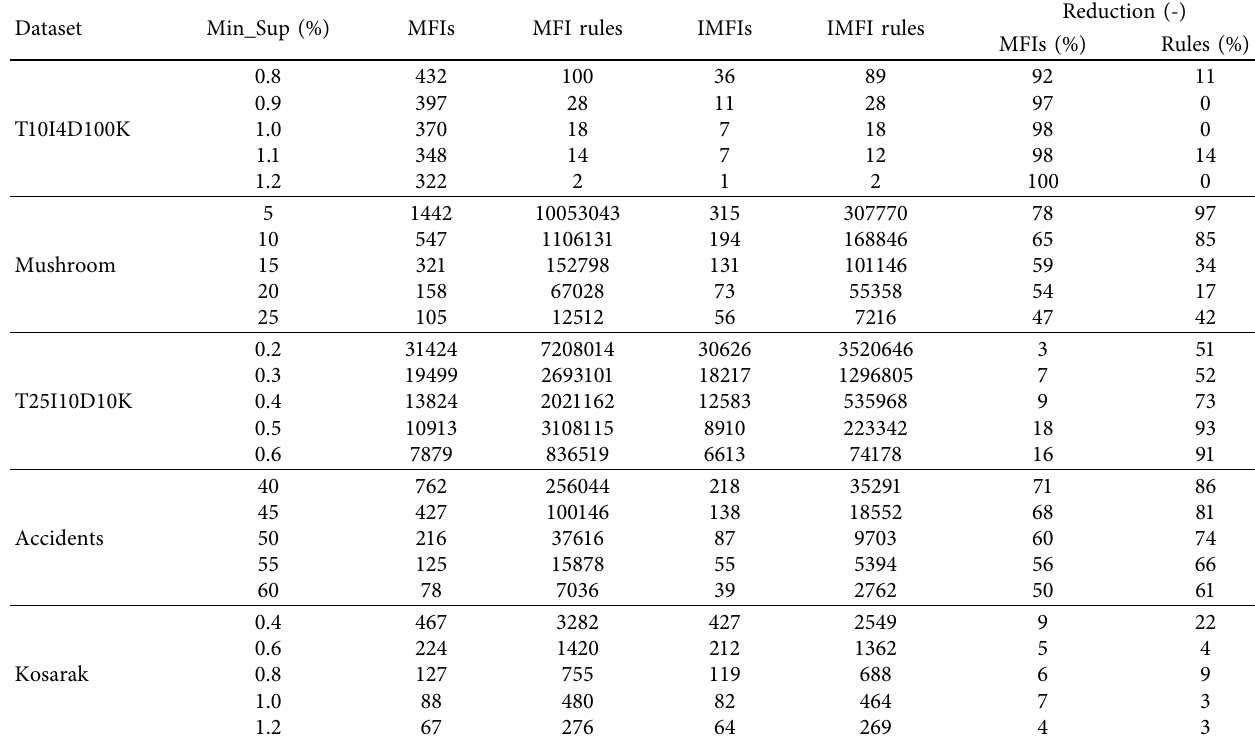
Table 15: Effect of NM on reduction in MFIs and rules when minNovlty � 0.2 and rules having Conf ≥ 0.7.